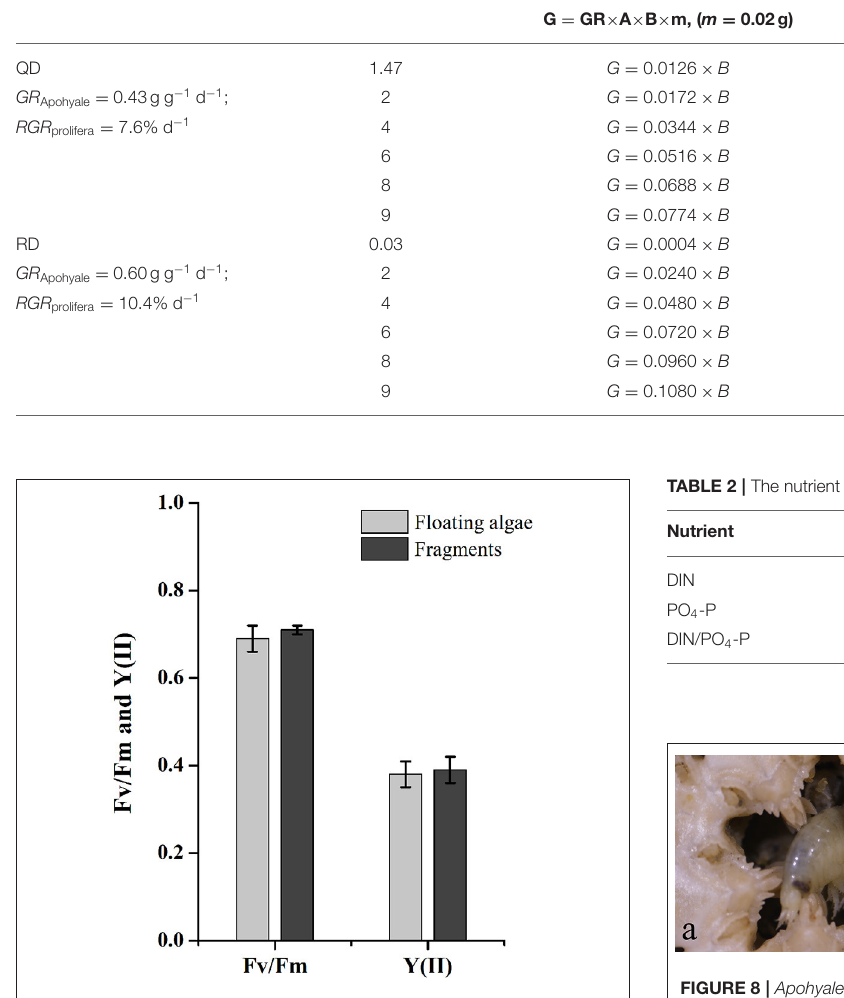
FIGURE 7 | Fv/Fm and Y(II) of floating U. prolifera algae and fragments. Error bars are SE ( n = 3).